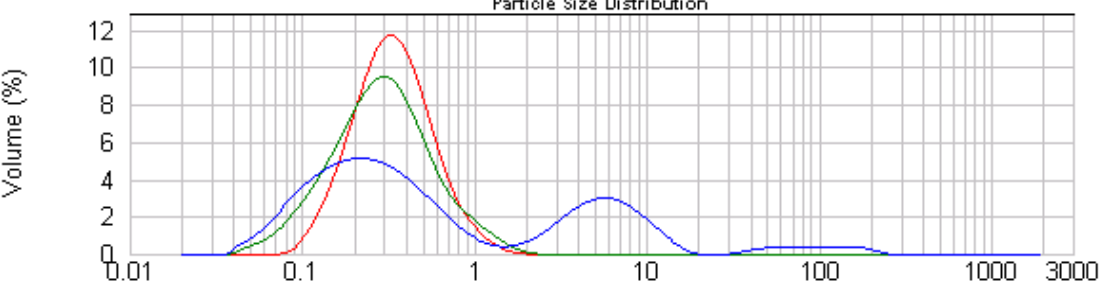
Figure 2. Particle size analysis for emulsions immediately after formation by high-pressure homogenization for top peak = control emulsion, (pH = 6.7); intermediate peak = emulsion containing 0.5% (w/w with aqueous phase) cranberry extract (pH = 5.6), and bottom peak = emulsion containing 1.0% (w/w with aqueous phase) cranberry extract (pH = 5.3).